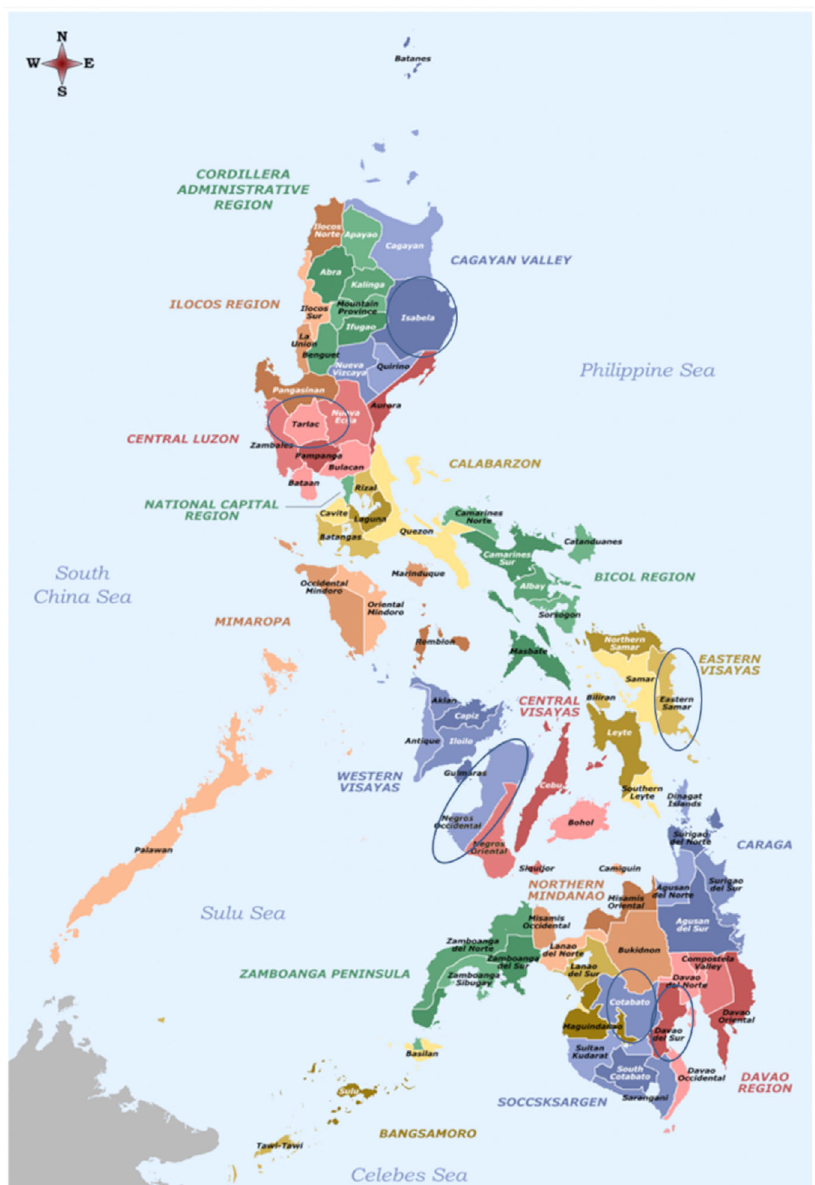
Fig. 1 Overview of the study areas. Overview of the selected six study areas within Luzon (Tarlac and Isabela), the Visayas (Eastern Samar and Negros Occidental) and Mindanao (Davao del Sur and Cotabato) where the research was